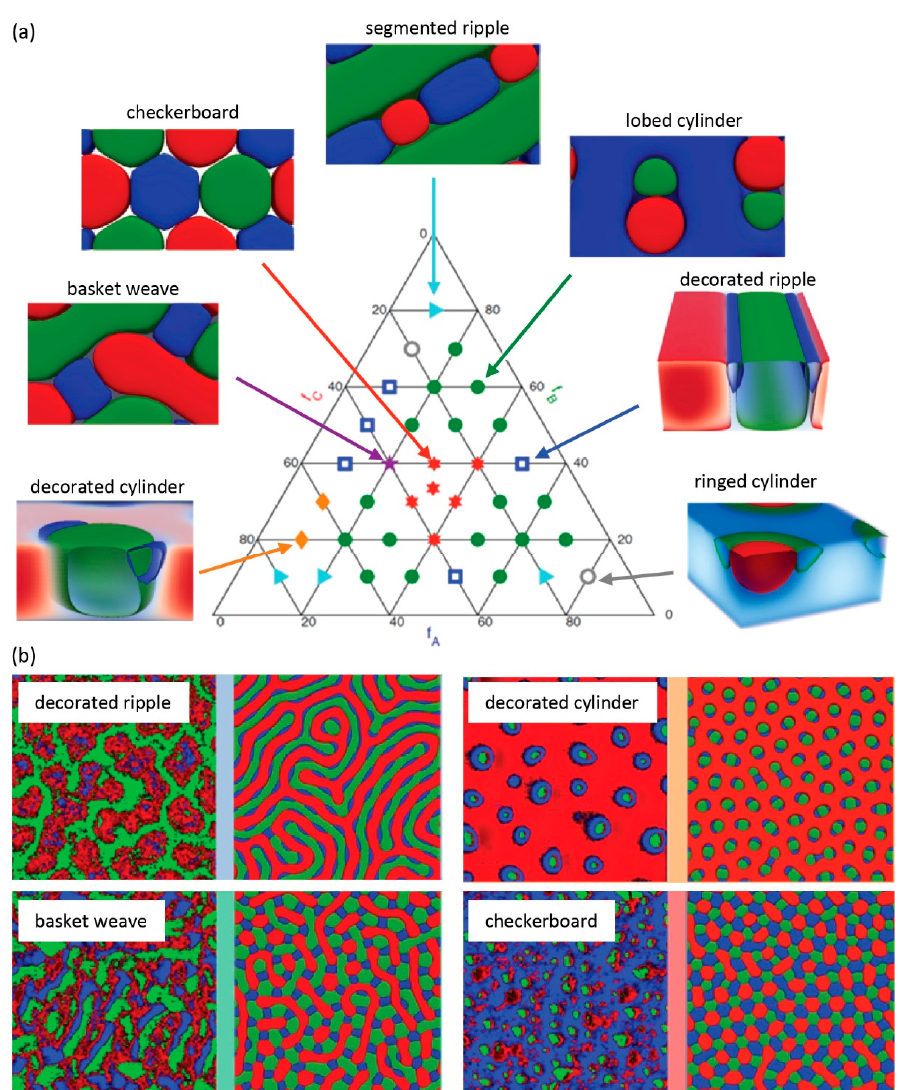
Figure 8. Nanostructures of ternary mixed polymer brushes: ( a ) phase diagram of possible nanostructures as a function of volume fraction of three components, ( b ) a comparison between (left) atomic force microscopy (AFM) result on polystyrene (PS)/ poly(methyl methacrylate) (PMMA) / poly(4-vinyl pyridine) (P4VP) and (right) simulation result of the corresponding volume fraction. (Reproduced with permission from Reference [43], Copyright 2016, American Chemical Society).